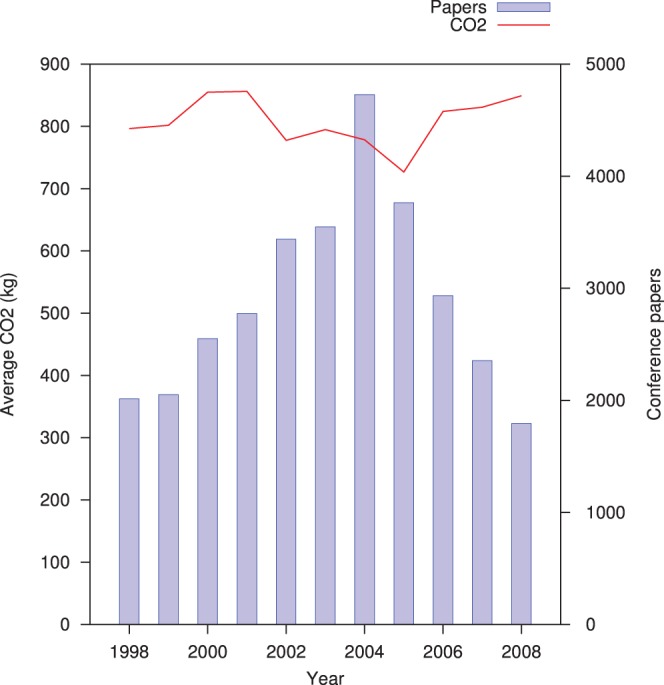
Conference travel CO2 per year.